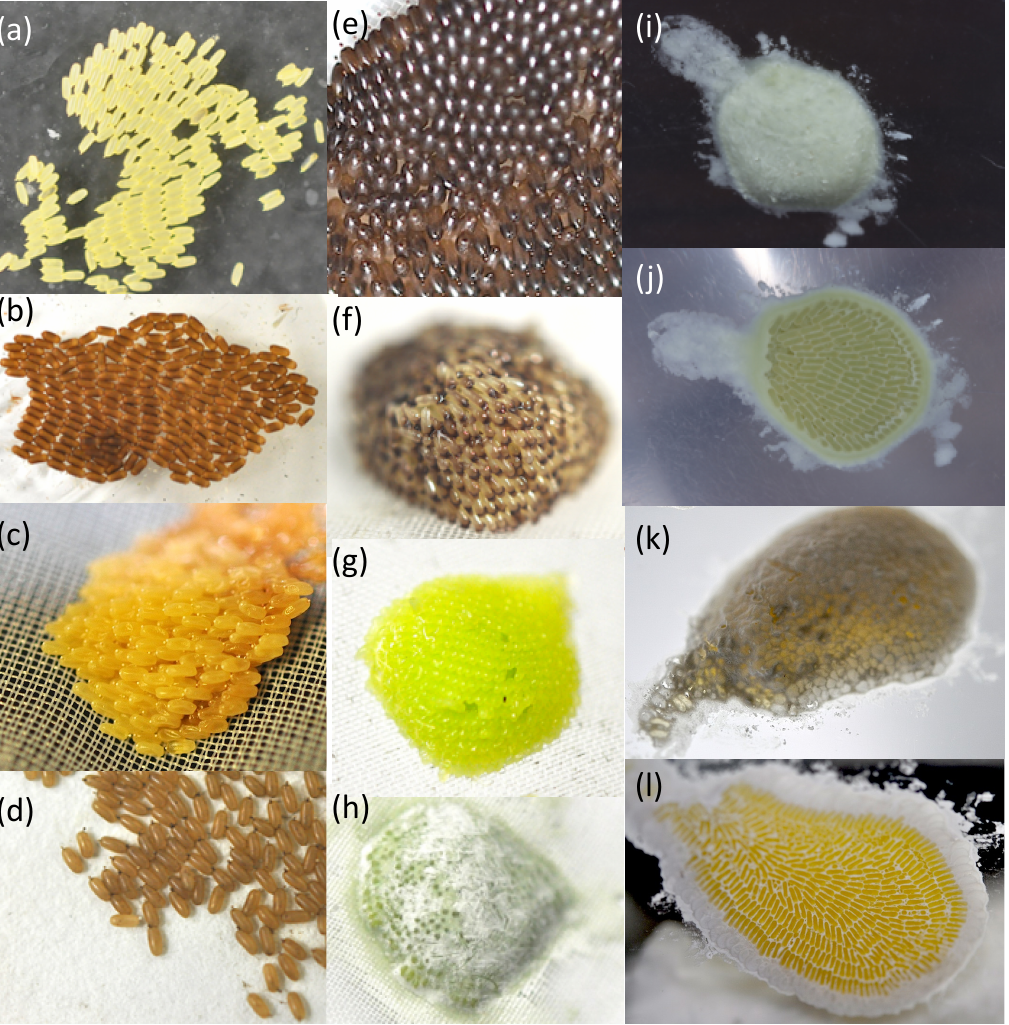
Figure 2. Typical egg masses of Megaloptera. ( a ) Sialis melania , in dorsal view; ( b ) Anachauliodes laboissierei , in dorsal view; ( c ) Nigronia serricornis , in dorsal view; ( d ) Parachauliodes japonicus , in dorsal view; ( e ) Parachauliodes continentalis , in dorsal view; ( f ) Protohermes grandis , in lateral-dorsal view; ( g ) Protohermes immaculatus , in dorsal view; ( h ) Nevromus sp., in dorsal view; ( i ) Neoneuromus ignobilis , in dorsal view; ( j ) ditto, in ventral view; ( k ) Acanthacorydalis fruhstorferi , in laterodorsal view; ( l ) ditto, in ventral view.